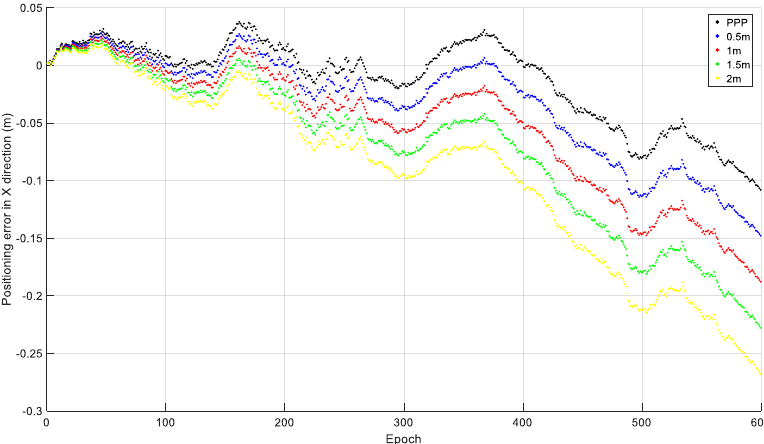
Figure 3. Positioning error in the X direction with different initial coordinates.